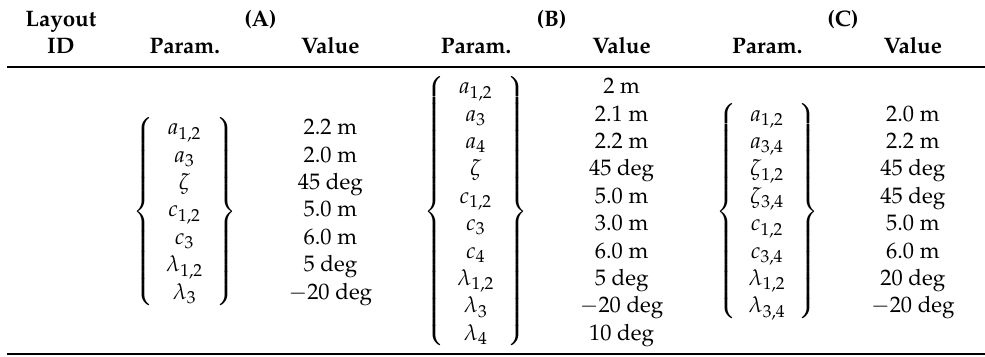
Table 3. Geometry settings for all considered configurations for SAS performance study.